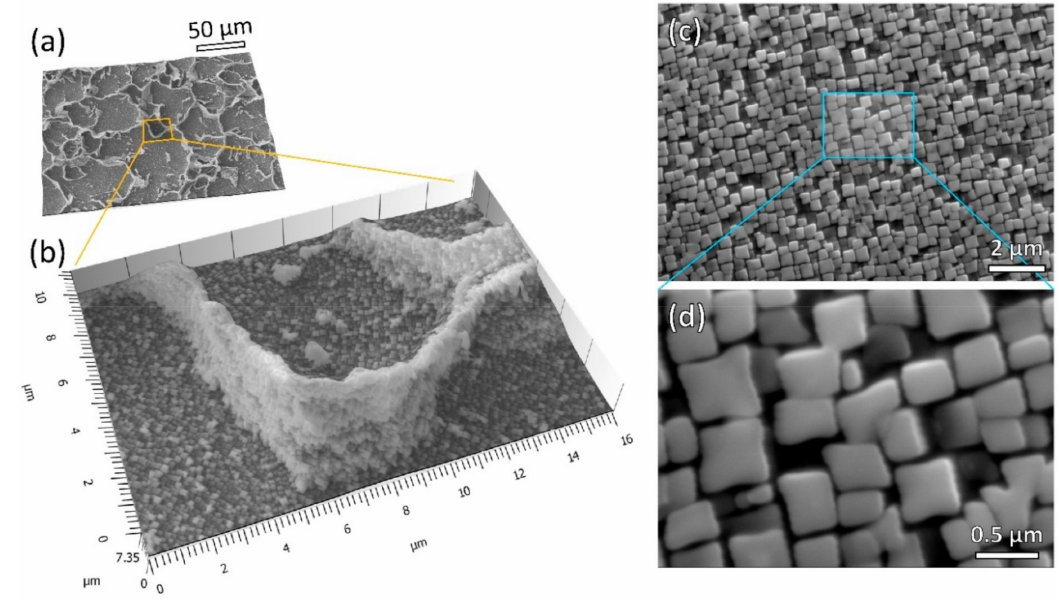
Figure 4. The γ (cid:48) precipitate morphology of MAD542 superalloy after post-processing heat treatment. ( a ) Stereo-image from SEM-secondary electron (SE) micrographs on a deep etched sample, showing a high amount of γ (cid:48) precipitate decorating the grain boundary region with an enlarged view in ( b ); ( c ) SEM-SE imaging of high density of γ (cid:48) precipitates observed in the grain interior region; ( d ) the enlarged view of cuboidal γ (cid:48)